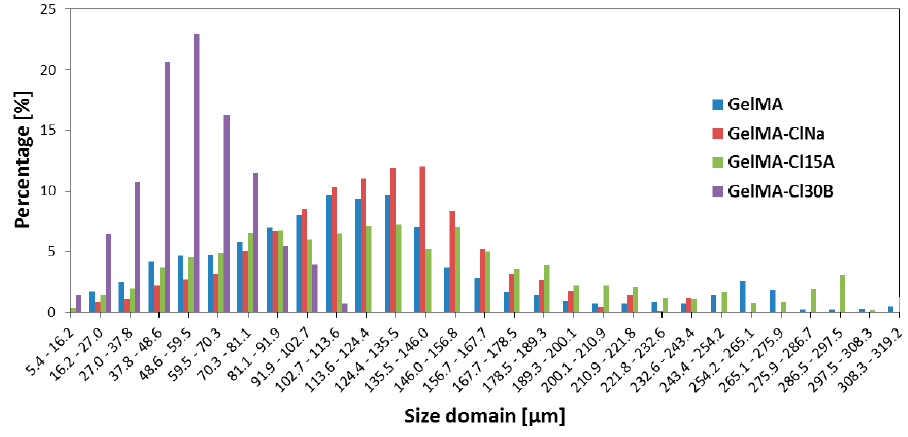
Figure 13. Micro-CT analyses—pore size distribution of GelMA and GelMA-based samples. The analysis of the roundness of open pores could offer a possible quantification of the printed shapes. Using SEM images and the Wadell equation [81], the average roundness of the open pores of the 3D printed scaffolds was calculated (Figure 14).